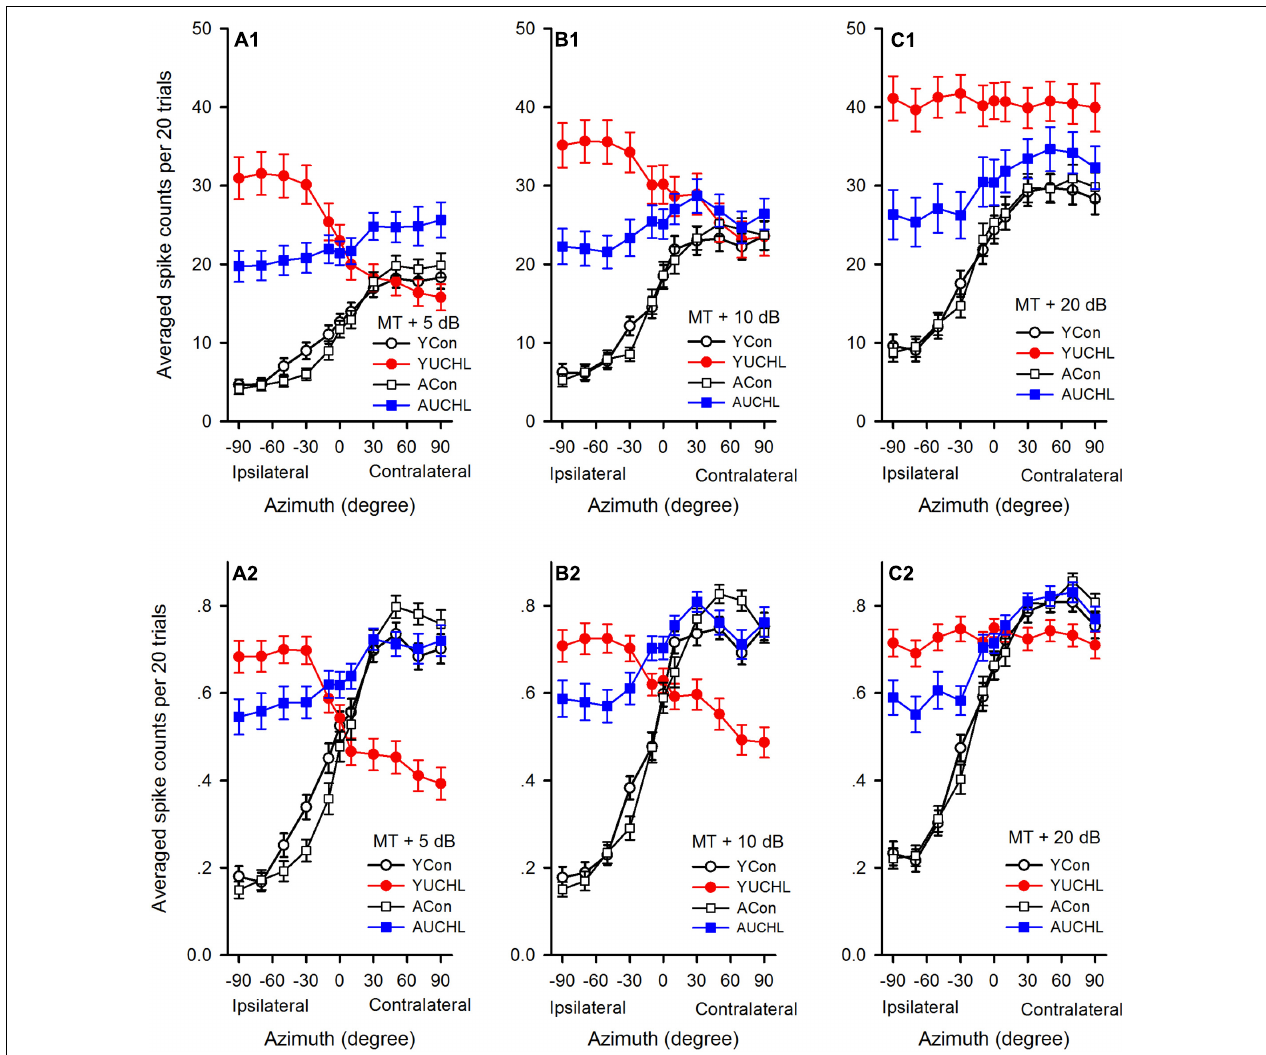
FIGURE 5 | Comparison of the average azimuth functions shown in spikes counts and normalized response strength for the population of AI neurons in the four groups of rats. (A1–C1) The average azimuth functions shown in spike counts. (A2–C2) The average azimuth functions shown in normalized response strength. The sound levels used to determine the azimuth functions are shown in the legend of each panel. YCon, young control; YUCHL, young unilateral conductive hearing loss; ACon, adult control; AUCHL, adult unilateral conductive hearing loss. The data are shown in mean and standard error.